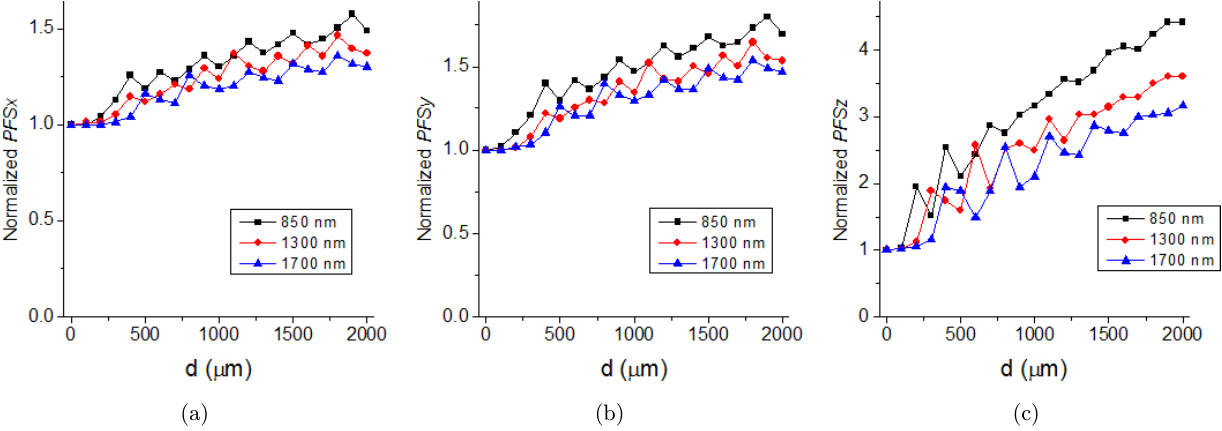
Fig. 2. Normalized two-photon (a) PSF x , (b) PSF y and (c) PSF z vs imaging depth for 850-nm, 1300-nm and 1700-nm excitations. All PSFs were normalized to those at the surface ( d ¼ 0). Also NA ¼ 1 : 05, n 1 ¼ 1 : 33 and n 2 ¼ 1 :